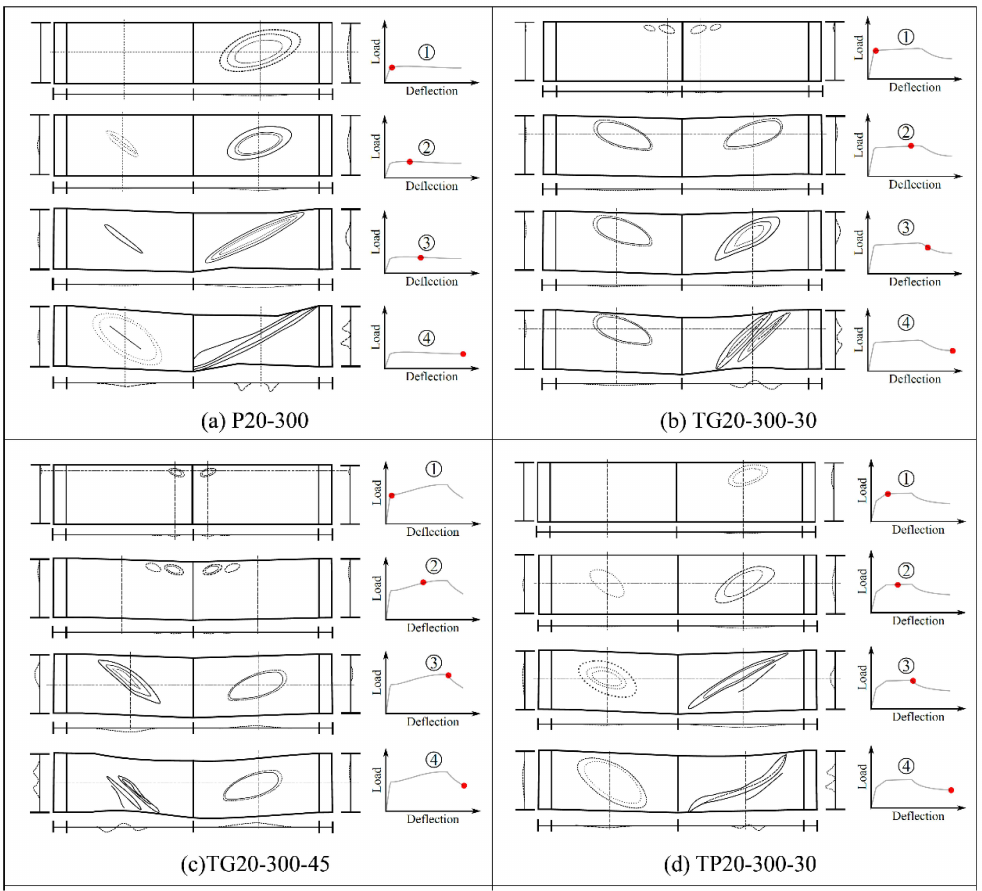
Figure 6. Web failure mechanisms of test specimens #1–4 at different loading stages ( a )